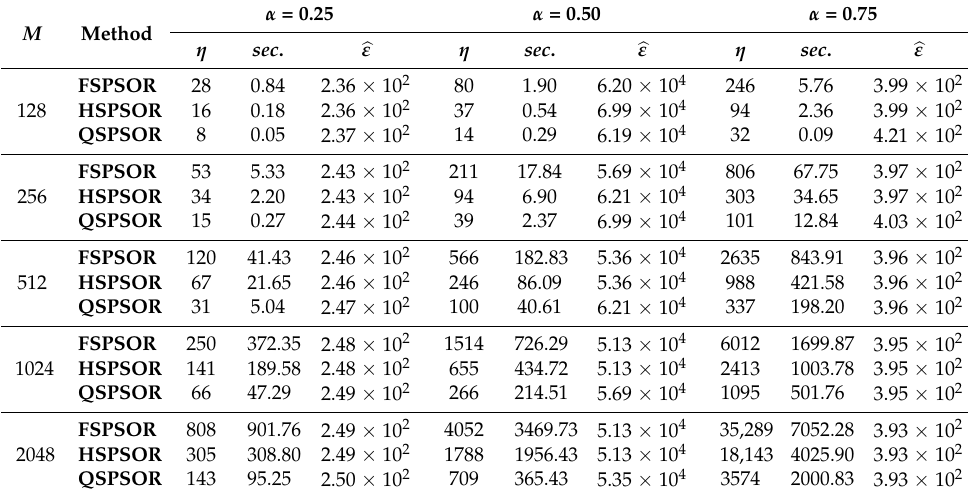
Table 3. Comparison between FSPSOR, HSPSOR, and QSPSOR in solving Example